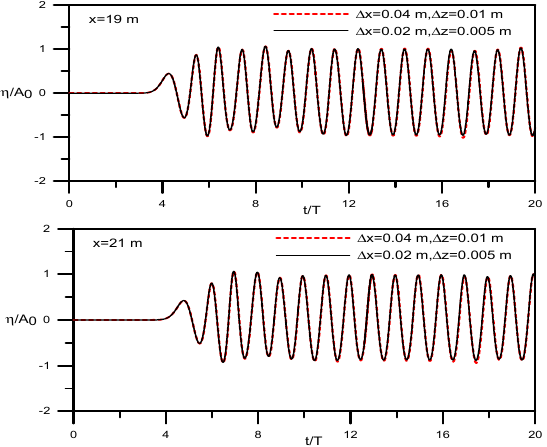
Figure 4. Simulation results for grid independent test using two different mesh sizes at the two gauge stations of x = 19 m (upper) and x = 21 m (lower). The condition of wave generation is identical to Figure 3.